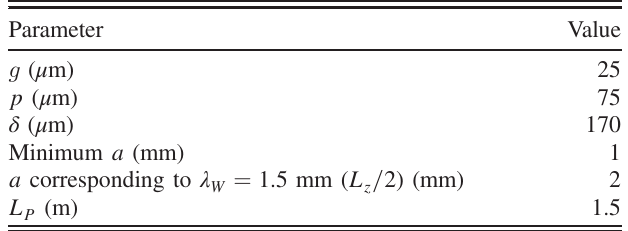
TABLE III. Parameters of the geometry of the corrugated plate optimized for